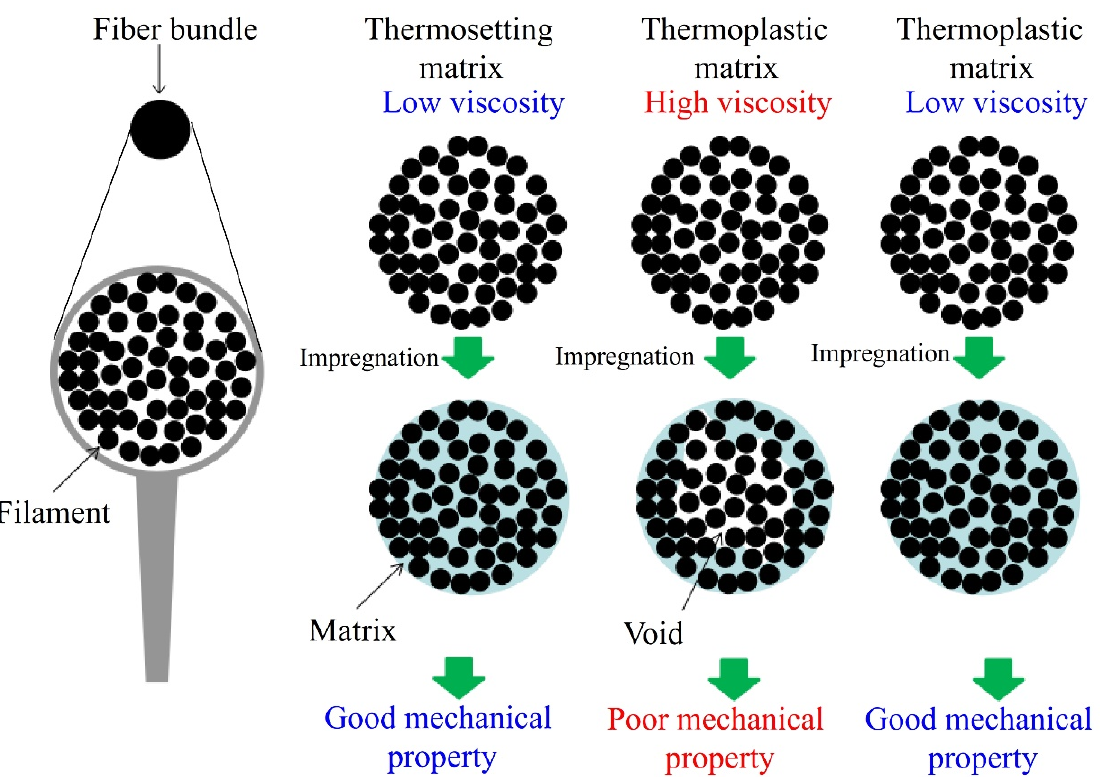
Figure 3. Diagram of relationship between viscosity and impregnation.